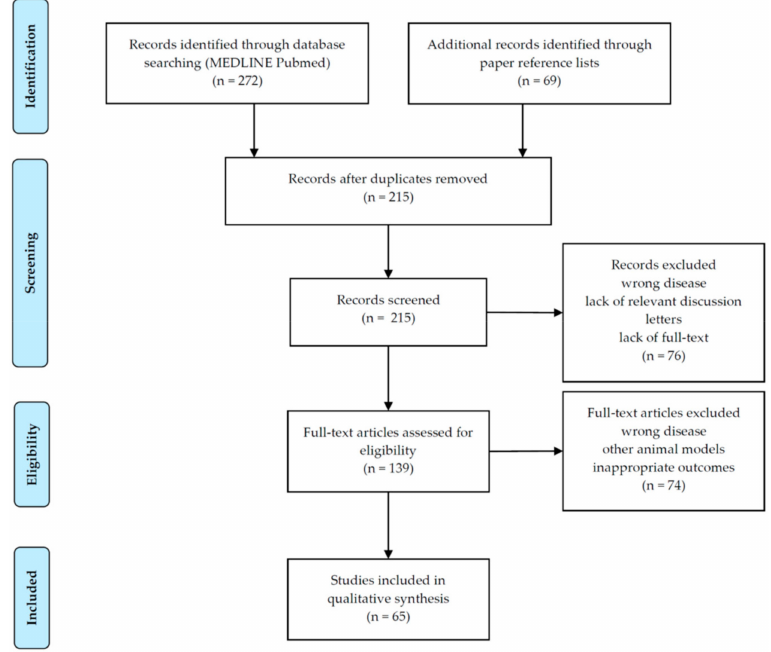
Figure 2. Selection of studies according to PRISMA flow diagram